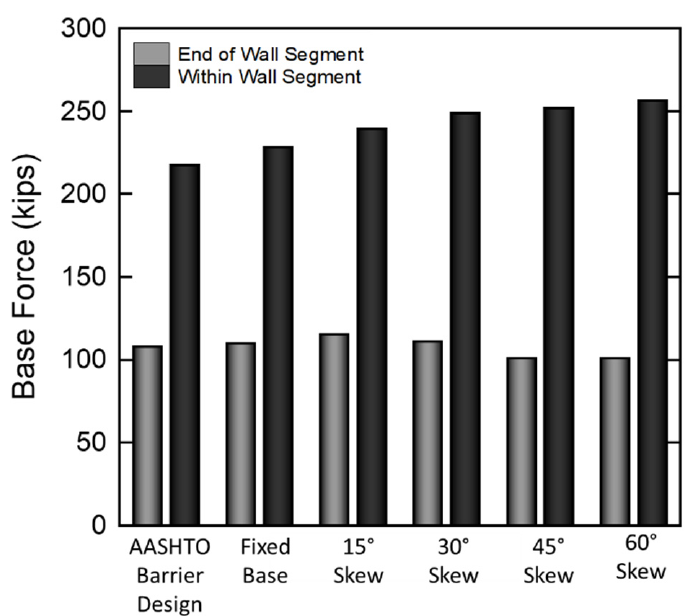
Figure 12. The comparison of parapet capacity between prototype bridge models, isolated parapet (fixed base) model and AASHTO yield line method.